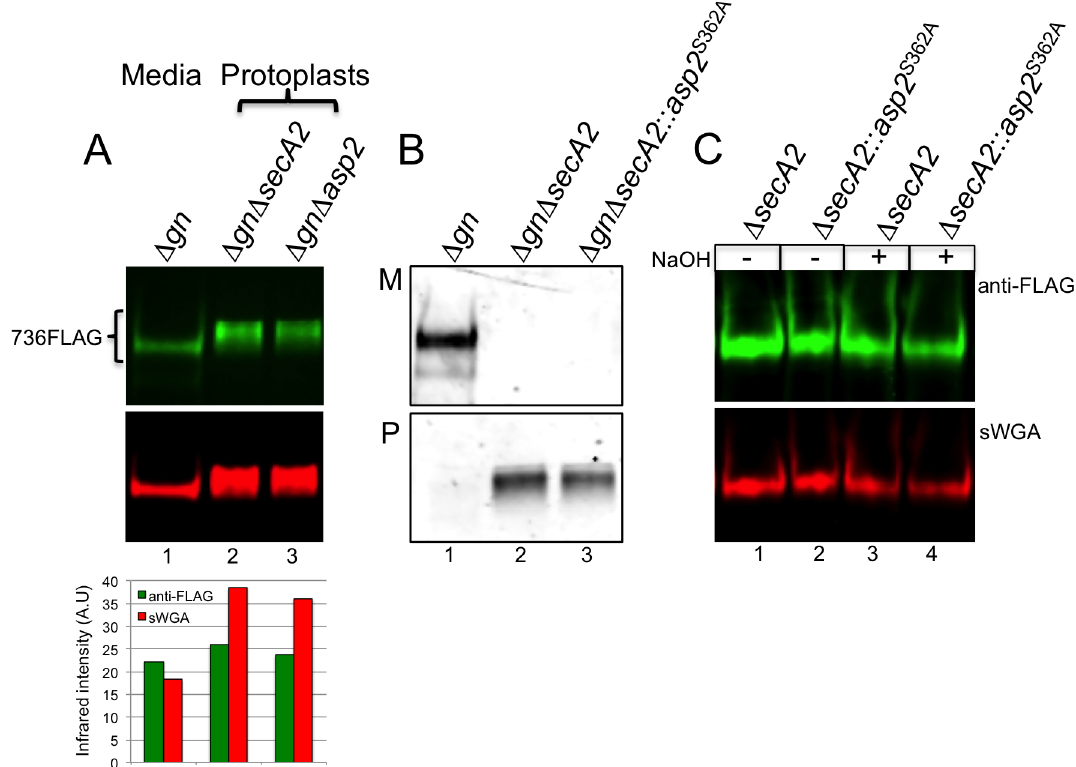
Fig 6. Effects of transport upon sWGA reactivity of GspB736flag. A) Upper panel shows Western blot analysisof GspB736flag exported from a nss and gly deletion( Δ gn )variant derivativestrain PS3309(lane 1) and intracellular GspB736flag expressedin the aSec deficient nss and gly deletionvariant strains PS3310(lane 2) and PS3584(lane 3). Anti-FLAG antibodieswere used to measureGspB736flagprotein levels, while GlcNAc reactivity was assessedby lectin blot analysisusing biotinylated sWGA as a GlcNAc probe. Lower panel shows densitometry analysisof GspB736flag levels and GlcNAc reactivity was determined by bandintensity analysisvia LI-COR imaging.B) Western blot analysisof GspB736flag exported from strains PS3309( Δ gn )(lane 1), PS3310( Δ gn Δ secA2 )(lane 2) and PS3605( Δ gn Δ secA2 :: asp2 S362A )(lane 3). (M) media fraction, (P) protoplast fraction. GspB736flagwas detected with anti-FLAG antibodies.C) GlcNAc reactivity of GspB736flag before and after saponfication of GspB736flagobtainedfrom protoplastsin the defined aSec background.Non-exported GspB736flagwas expressedin the followingaccessory Sec/ Δ gn deletionstrains, PS3310 (lane 1), PS3605(lane 2). SaponifiedintracellularGspB736flag was achievedthrough incubation with 100 mM NaOH to release ester-linked acetate. Western and lectin blot analysisof secreted GspB variants, together with corresponding densitometry analysis, are representative of at least three different genetic transformants analyzedfor each